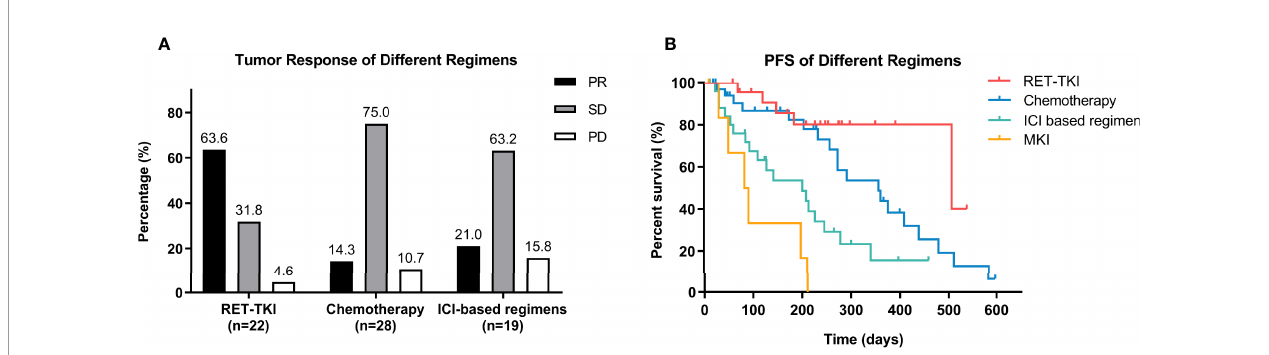
FIGURE 2 | Ef fi cacy analysis of different regimens in overall patients. (A) Tumor response of different regimens including RET-tyrosine kinase inhibitors (RET-TKI) or chemotherapy or immune-checkpoint inhibitor (ICI)-based regimens or multi-kinase inhibitor (MKI). (B) Progression-free survival (PFS) of patients treated with RET-TKI or chemotherapy or ICI-based regimens or MKI. PR, partial response; SD, stable disease; PD, progressive disease.